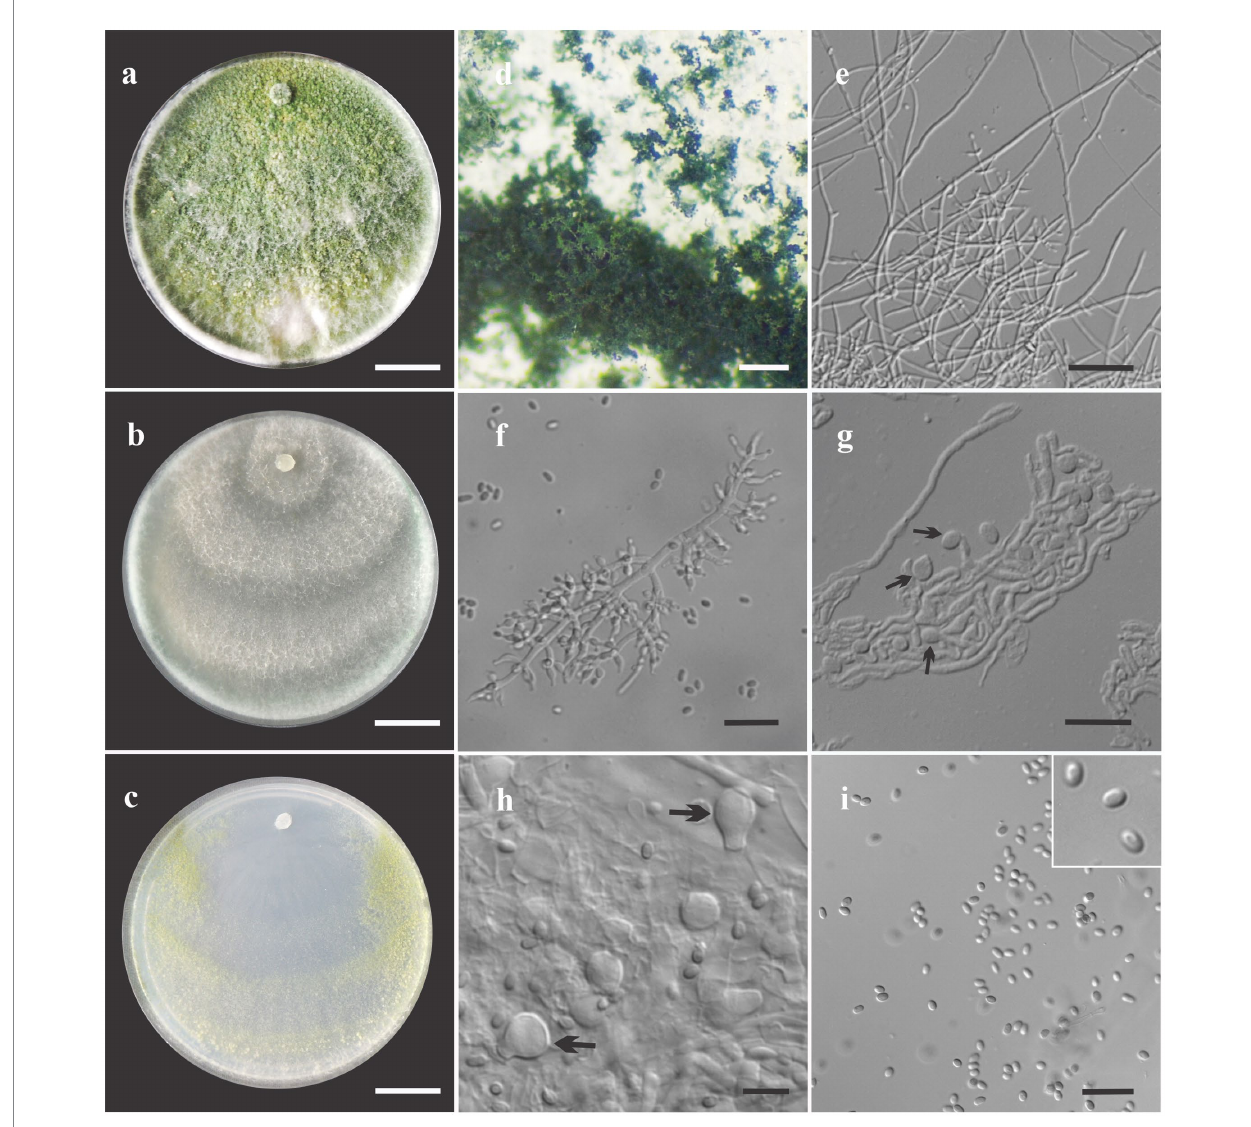
FIGURE 4 Asexual morph of Trichoderma ararinum sp. nov. from Hevea brasiliensis (VIC47509, holotype). ( A–C ) Colony appearances (PDA, CMD, and SNA; 7 days, 25 ° C). ( D ) Sporulating pustules (SNA). ( E , F ) Conidiophores and phialides (SNA). ( G ) Chlamydospore (after 48 h). ( H ) Chlamydospore (after 7 days). ( I ) Conidia. Scale bars: ( A–C ) 20 mm, ( D ) 0.2 mm, ( E ) 50 μ m, ( F , G , I ) 20 μ m, and ( H ) = 10 μ